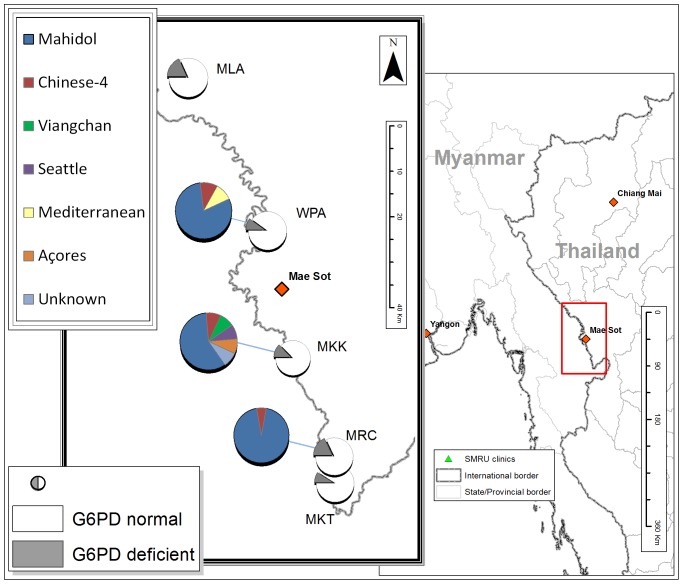
Geographic distribution of G6PD deficient variants detected in five SMRU clinics along the Thailand-Myanmar border.The map indicates the geographic location of the five SMRU clinics where G6PD phenotypes and genotypes were investigated. The white and grey pie charts indicate the proportion of samples taken in each clinic that were either G6PD normal (white) or G6PD deficient (grey). The second-layer pie charts indicate the genetic variants causing phenotypic deficiency at the corresponding site. In two clinics, MLA and MKT, only Mahidol variant was found.